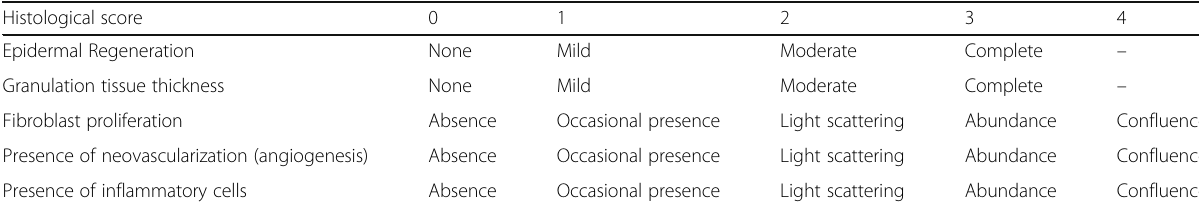
Table 2 Histological features of wound healing Histological score 0 Epidermal Regeneration None Granulation tissue thickness Presence of neovascularization (angiogenesis) Presence of inflammatory cells Absence (A modification of Altavilla et al. [25], Lee et al. [26] and Gopalakrishnan et al.